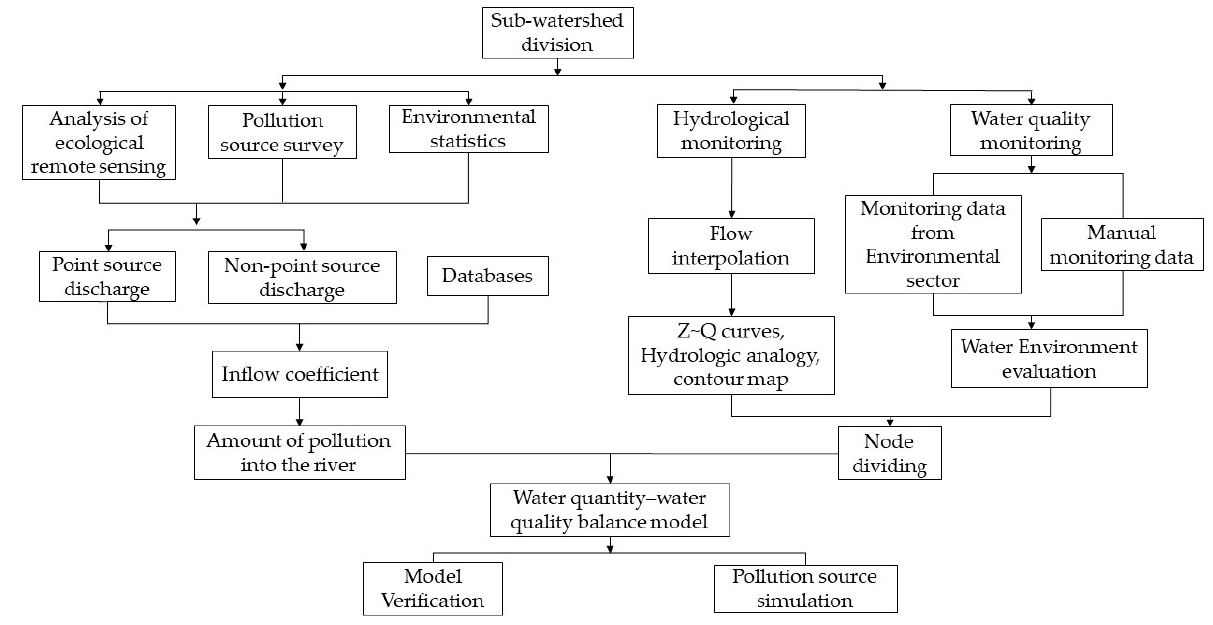
Figure 1. Workflow of this study.